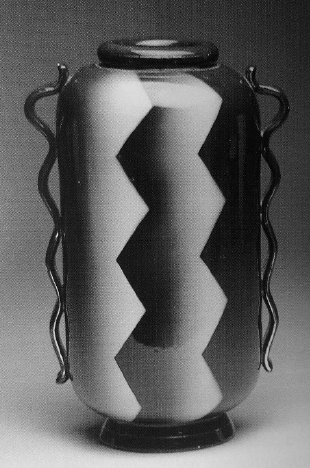
Figure 4. Vase with handles, Manifattura Galvani (Pordenone), designed by Angelo Simonetto, mid-1930s. Private collection. Photo took by author.